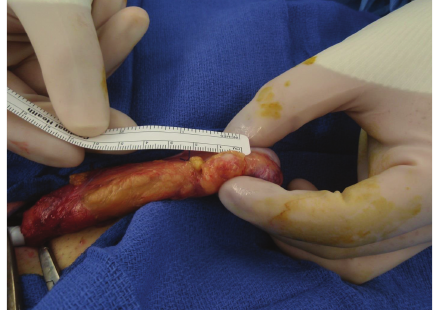
Figure 2: Intraoperative photograph demonstrating complete mobilization of the right spermatic cord, with proximal control achieved with a Penrose drain. The paratesticular lesion is depicted superior to the right epididymis, with a moderate amount of fat surrounding the mass.